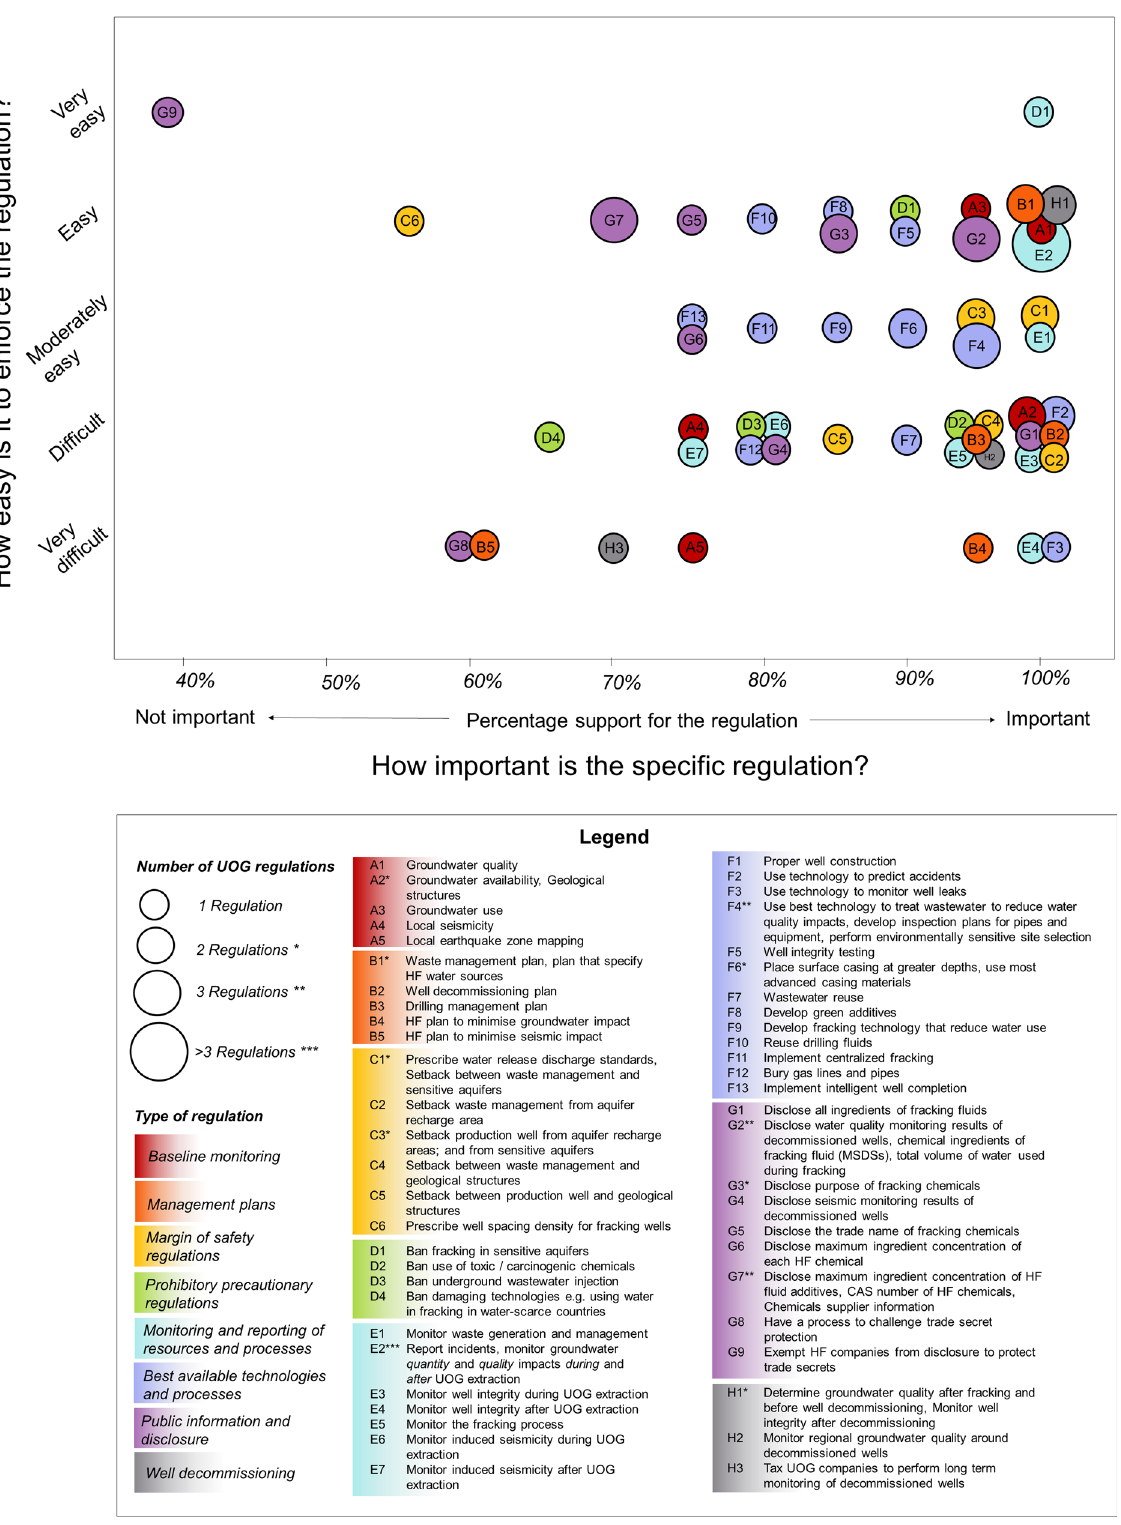
Fig. 2 Importance and ease of enforcement of proposed groundwater regulations ( n = 20). Percentage of respondents viewing speci fi c UOG extraction regulations for protecting groundwater resources as important and how easy respondents think their enforcement would